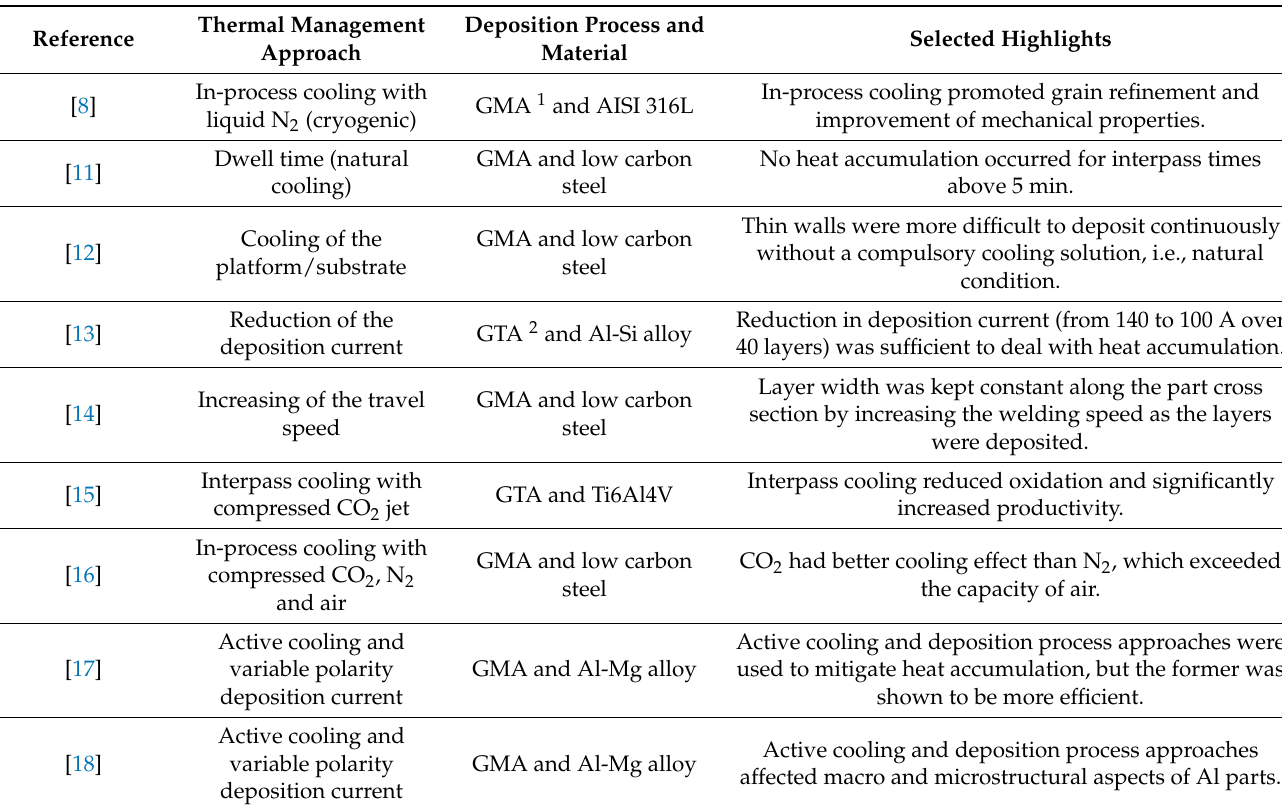
Table 1. Some typical thermal management approaches for WAAM reported in the recent literature and their selected highlights.